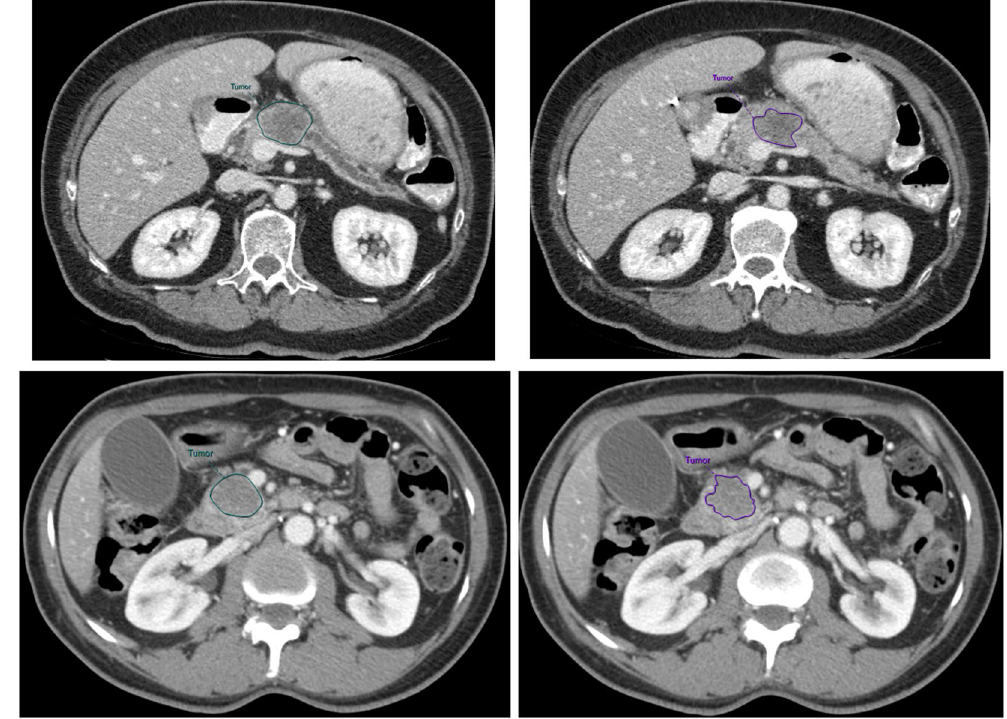
Figure 4. Representative patients from the validation cohort contoured for tumour with specific survival and radiomic signature values as follows: Left: Experienced Reader (Reader 1), Right: Inexperienced Reader (Reader 2). Top: Survival time: 4 months, Radiomic Signature - Reader 1: 1.25, Reader 2: 1.80. Bottom: Survival time: 44 months; Radiomic Signature - Reader 1: 0.49, Reader 2: